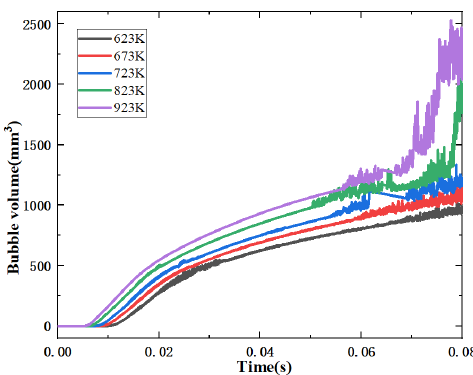
Figure 12. Vapor bubble distributions in capillary outlet section at different times: ( a ) 0.01 s ( b ) 0.05 s